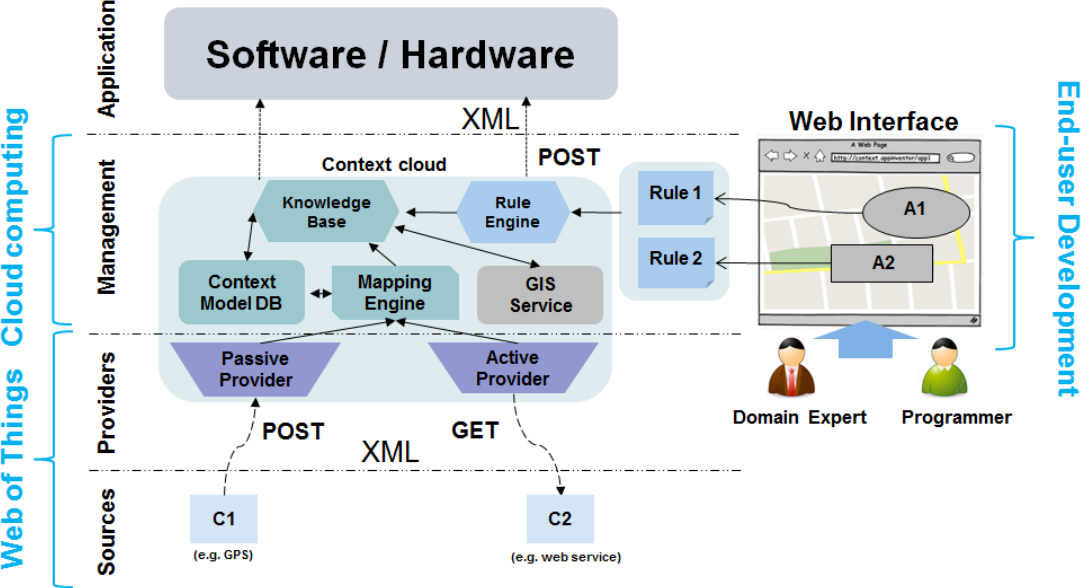
Figure 4. Architecture of Context